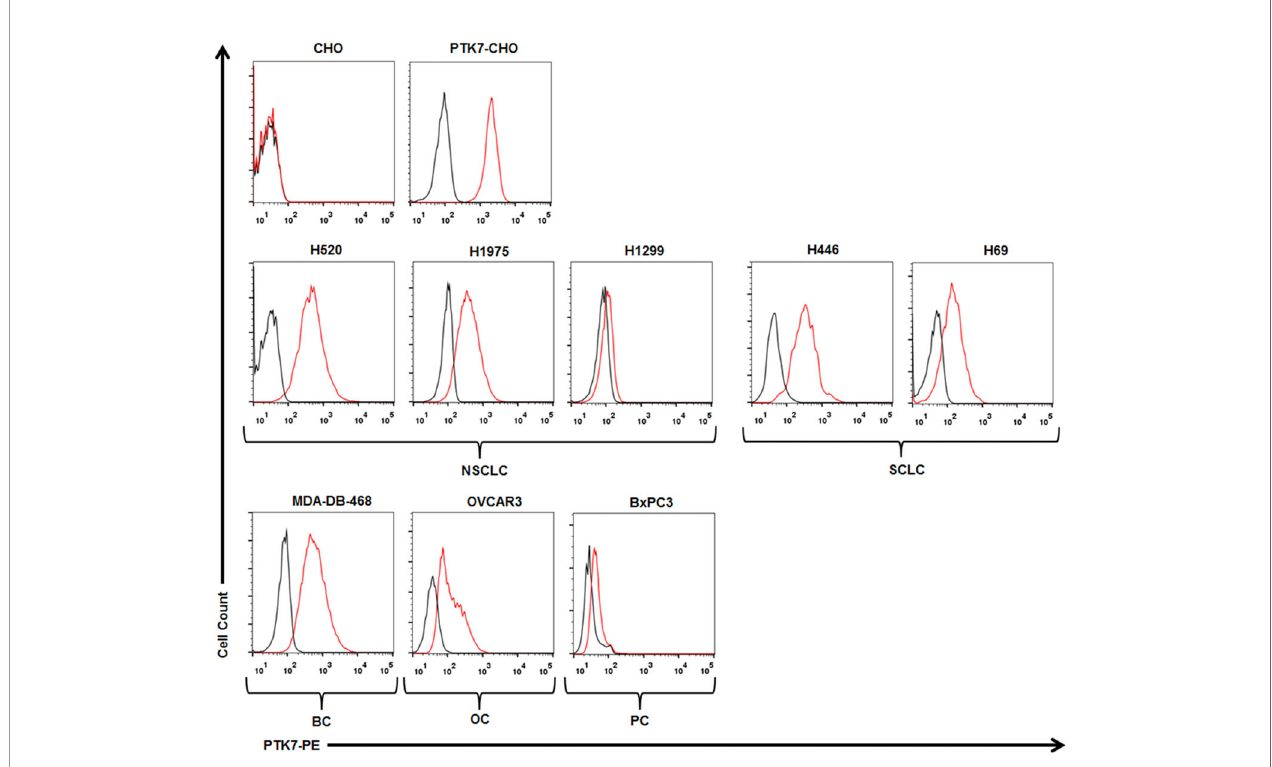
FIGURE 2 | PTK7 is overexpressed on several tumor cell lines. CHO and PTK7-CHO cells served as negative and positive controls, respectively. PTK7 overexpression was observed on NSCLC (H520, H1975, H1299), SCLC (H446, H69), MDA-DB-468 breast cancer (BC), BxPC3 pancreatic cancer (PC), OVCAR3 ovarian cancer (OC) cells. Black and red lines denote the control (secondary antibody alone) and PTK7 staining,